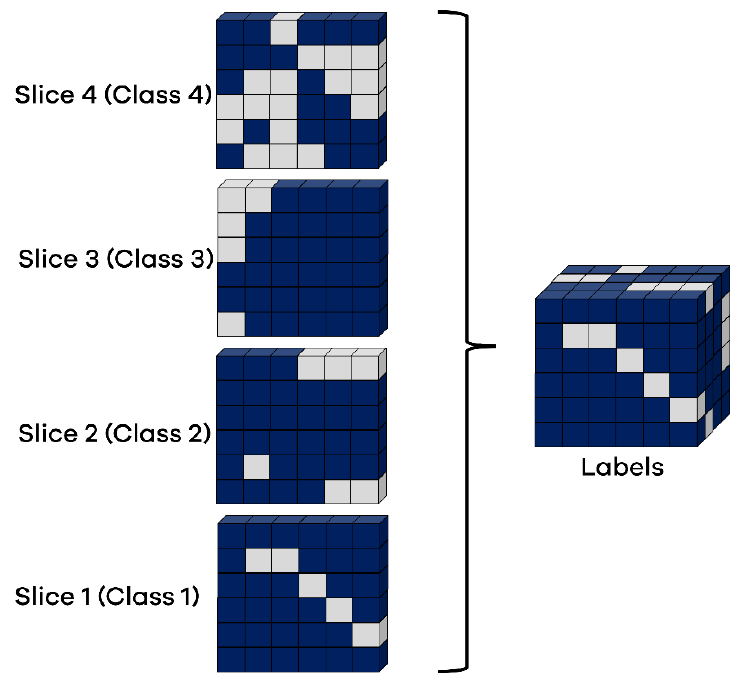
Figure 4. Class slices. White pixel is the labeled class, and blue pixel is the other classes.